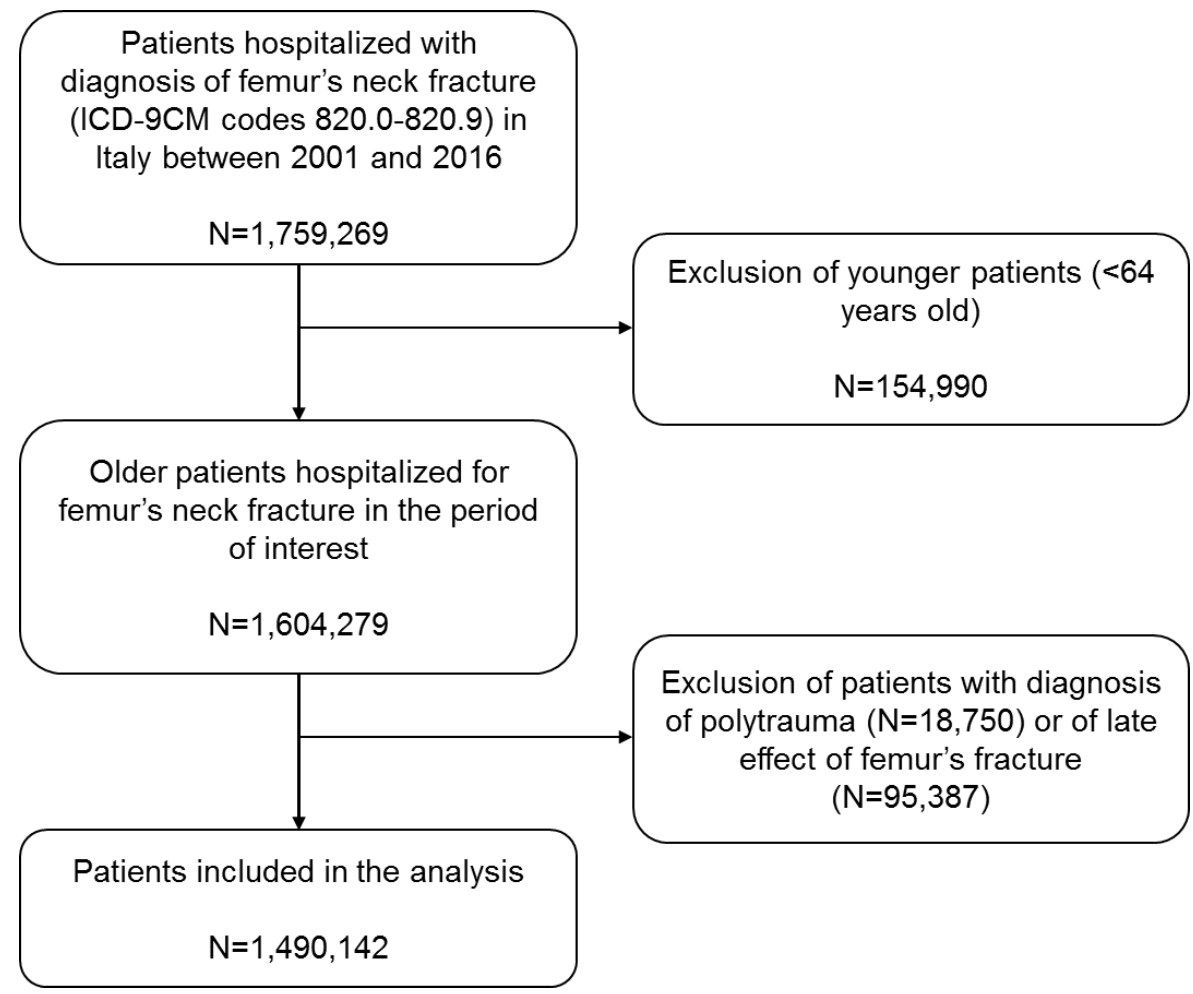
Figure 1. Flow chart of patients’ selection process .